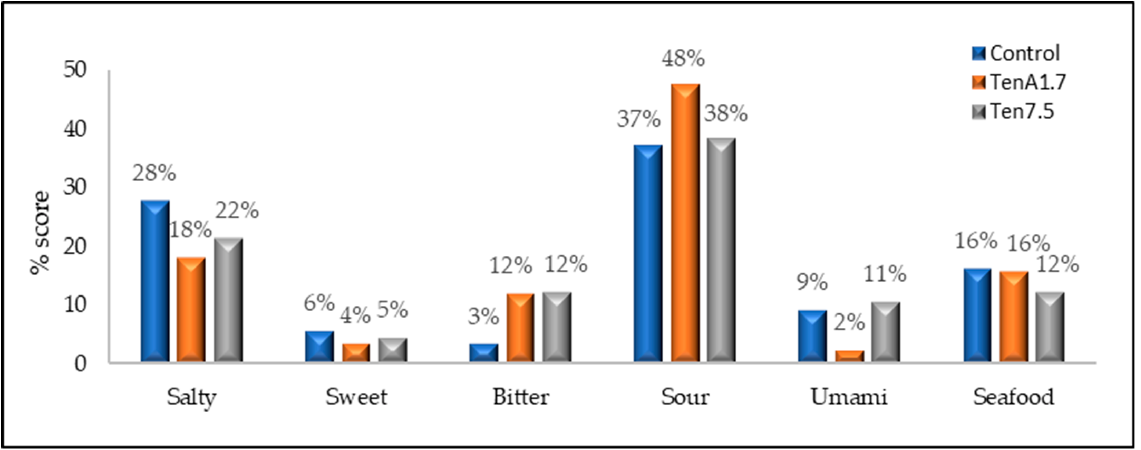
Figure 8. Average responses of the panelists ( n = 47) for the control and the formulations with 1.7 % and 7.5 % Tenebrio molitor flour for the different flavors identified.